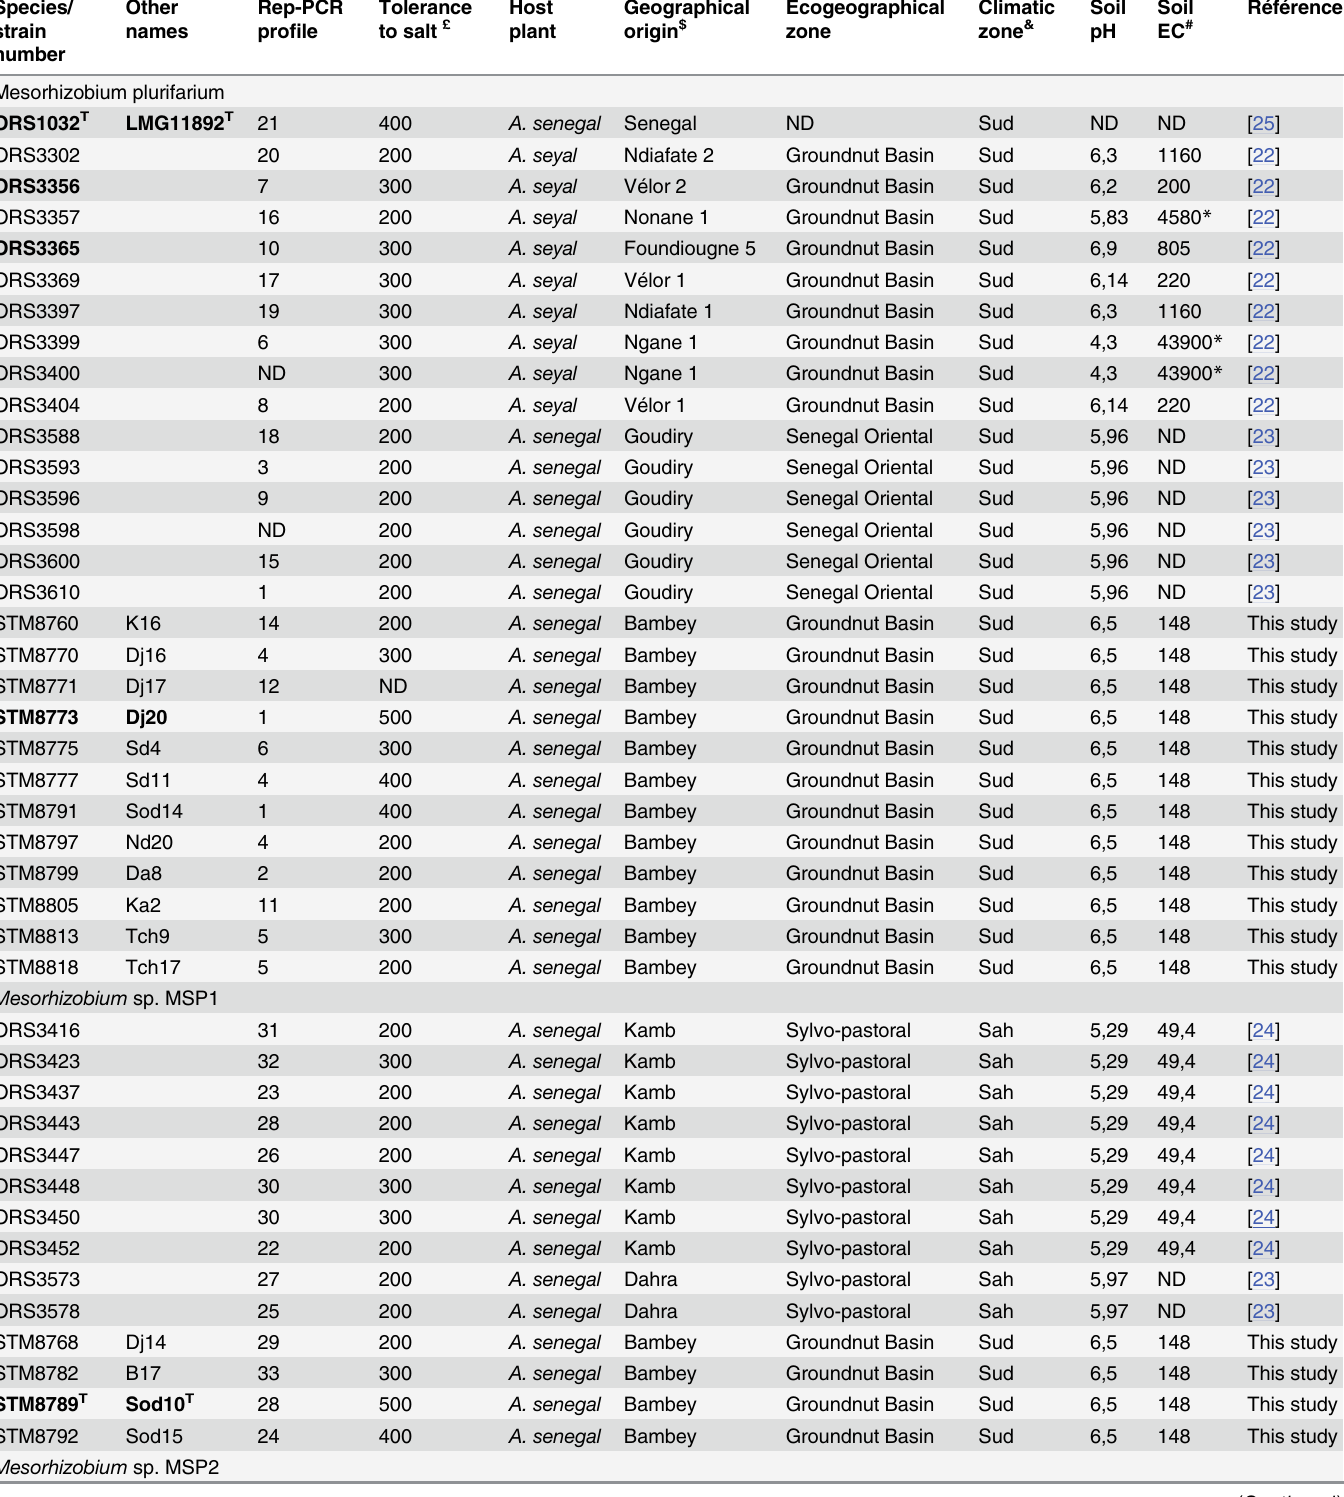
Table 1. Bacterial collection of Acacia symbionts used in this